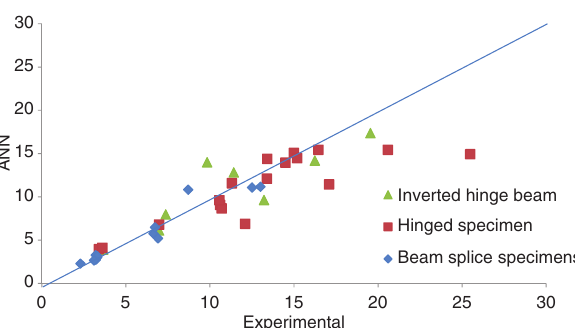
Figure 15: Comparison of ANN models for testing data of each beam type specimen (inverted hinge beam specimens, hinged specimens and beam splice specimens).